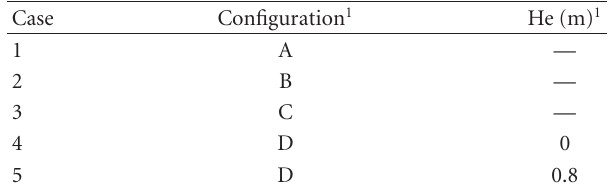
Table 8: Definition of simulated